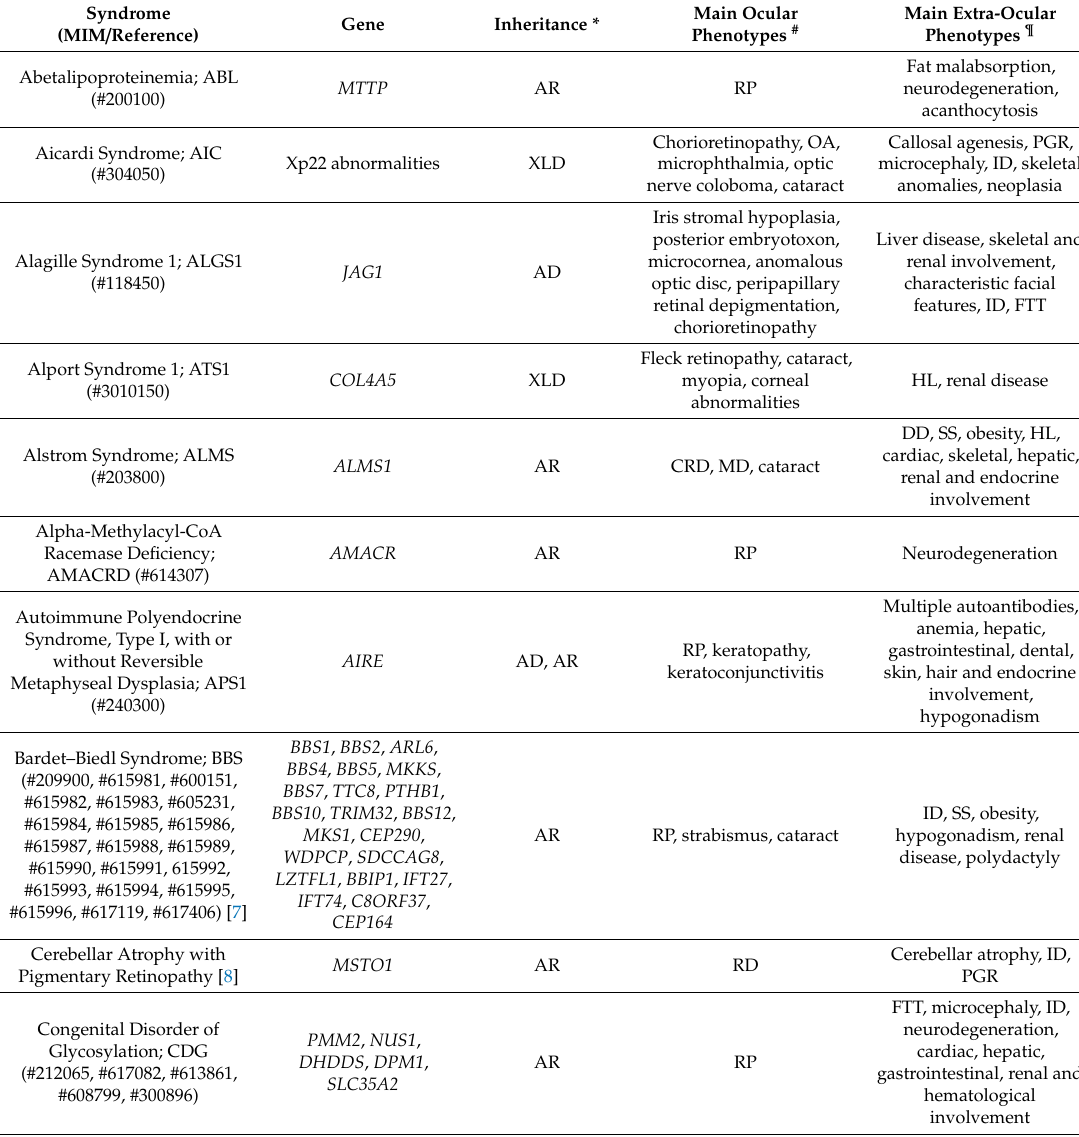
Table 1. Syndromic inherited retinal diseases